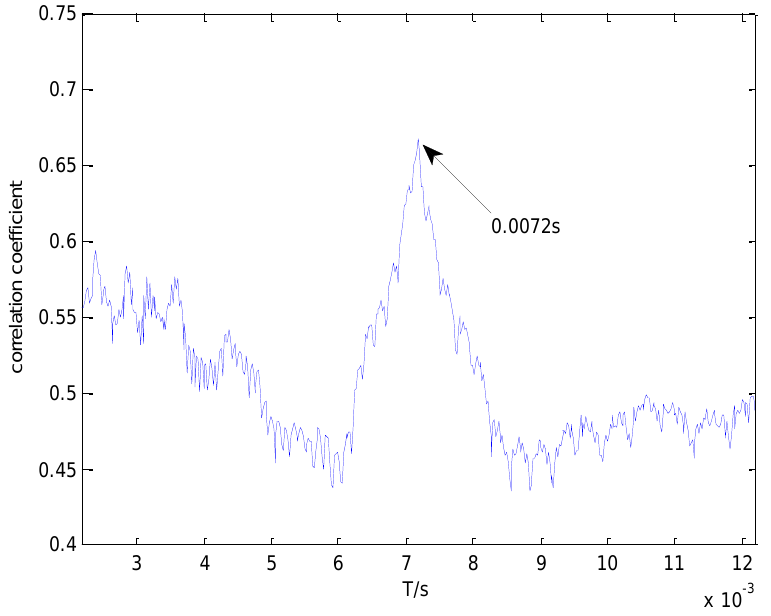
Figure 15. Maximal correlation coefficients for different elements from set T.